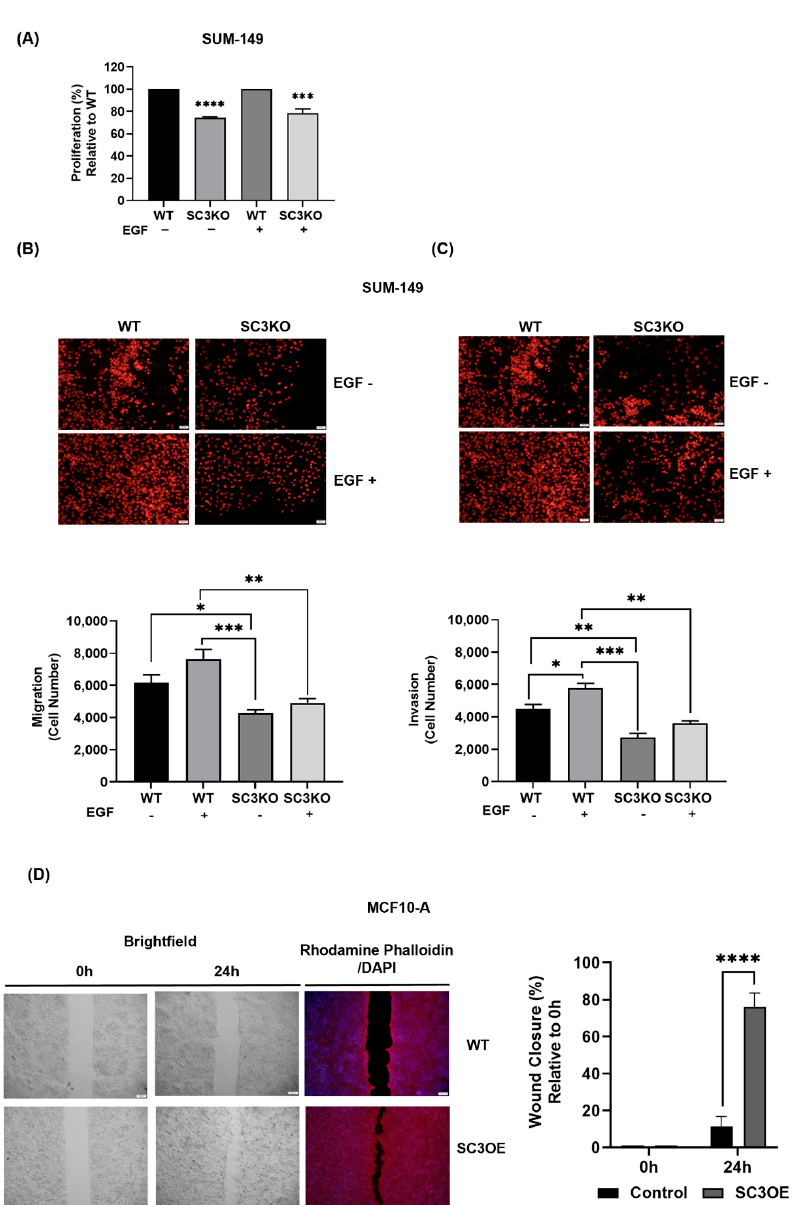
Figure 5. SCAMP3 modulates TNBC cell proliferation and motility through EGFR. ( A ) SUM-149 WT and SC3KO cells were stimulated with 10ng/mL of EGF for 30 min and proliferation was measured after 72 h using the Cell Proliferation Kit I (MTT). Data are expressed relative to WT without (EGF-) or after stimulation (EGF+). One-way ANOVA; *** p < 0.001 and **** p < 0.0001. EGF-stimulated SUM-149 WT stimulated with EGF and SC3KO were incubated in migration and Matrigel invasion chambers for 24 h to assess ( B ) migration and ( C ) invasion ability of cells. The nuclei of the migrating and invading cells were stained with PI. Illustrations represent 14 micrographs per condition at a magnification of 200 × ; scale = 100 µ m. Cells were counted using ImageJ. Two-way ANOVA; * p ≤ 0.05, ** p < 0.01, *** p ≤ 0.001. ( D ) Wound healing assay of MCF-10A control and SC3OE cells using silicone insert Ibidi ® plates after 24 h. The width of the wound was determined by measuring the distance between the edges of the wound. The nuclei were stained with DAPI (blue) and the actin cytoskeleton was stained with Rhodamine Phalloidin (red). Micrographs were taken at a magnification of 400 × ; scale = 200 µ m. Data are expressed as percent relative to 0 h and analyzed relative to control cells. t -test: **** p ≤ 0.0001. Data are represented as mean ± SEM. The experiments were carried out at least three